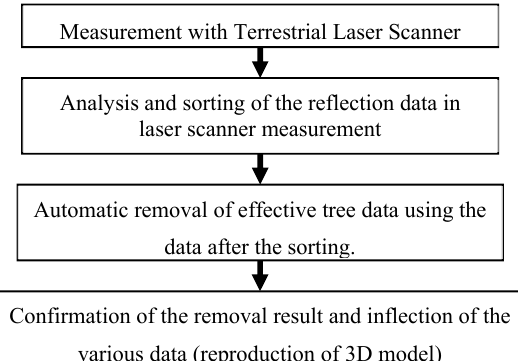
Figure1. Work flow about automatic removal of the tree using